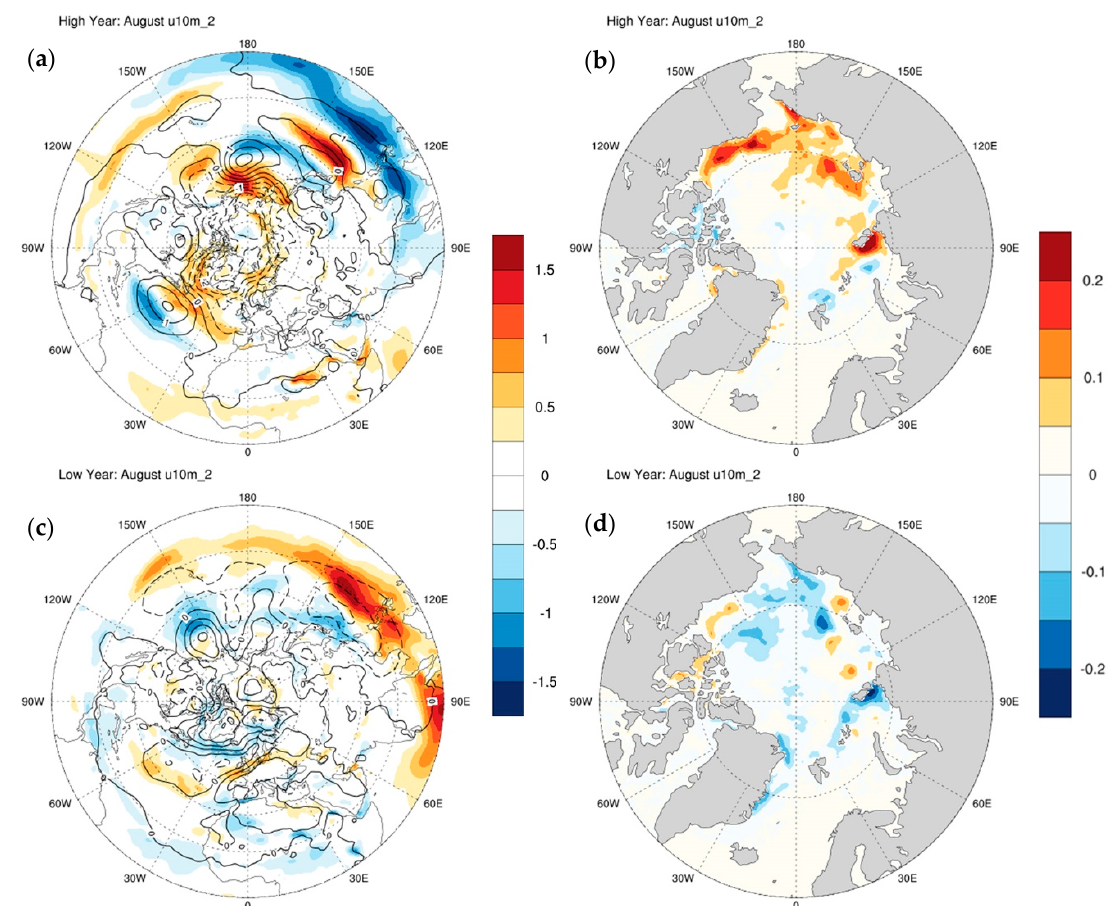
Figure 7. Composite anomalies of ( a , c ) August zonal component of wind at 10 m (shade interval: 0.25 m/s) and sea-level pressure (contour interval: 0.5 hPa); and ( b , d ) September SIC (shade interval: 0.05). The top (bottom) two plots correspond to the years when August u10m_2 (10.3 ◦ N, 9.9 ◦ E) is one standard deviation larger than its climatology mean in the positive (negative) phase.